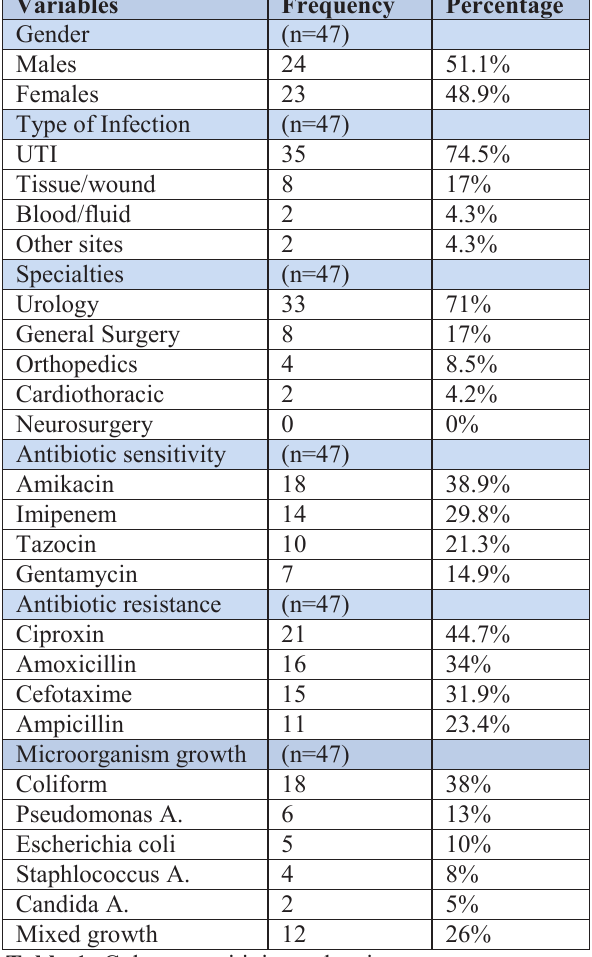
Table-1: Culture sensitivity and resistance pattern